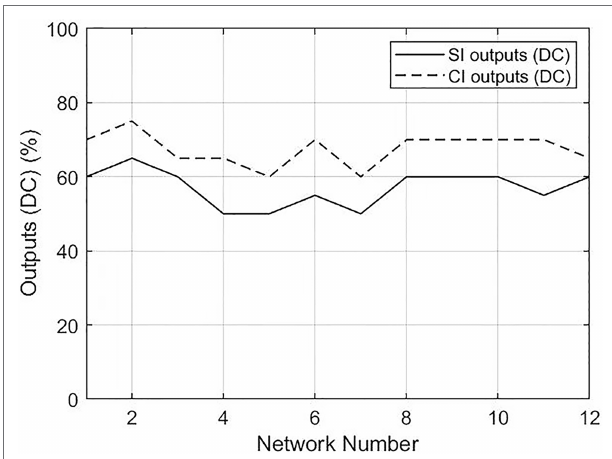
FIGURE 7 | Distributions of percentages of function words in the top 20 values between SI and CI outputs. DC, degree